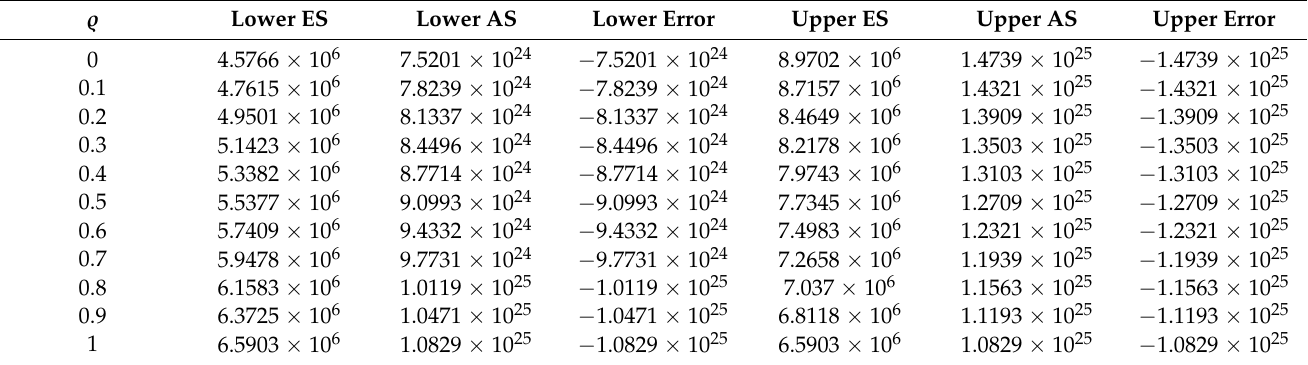
Table 2. Table for the error term between exact solutions (ES) and approximate solutions